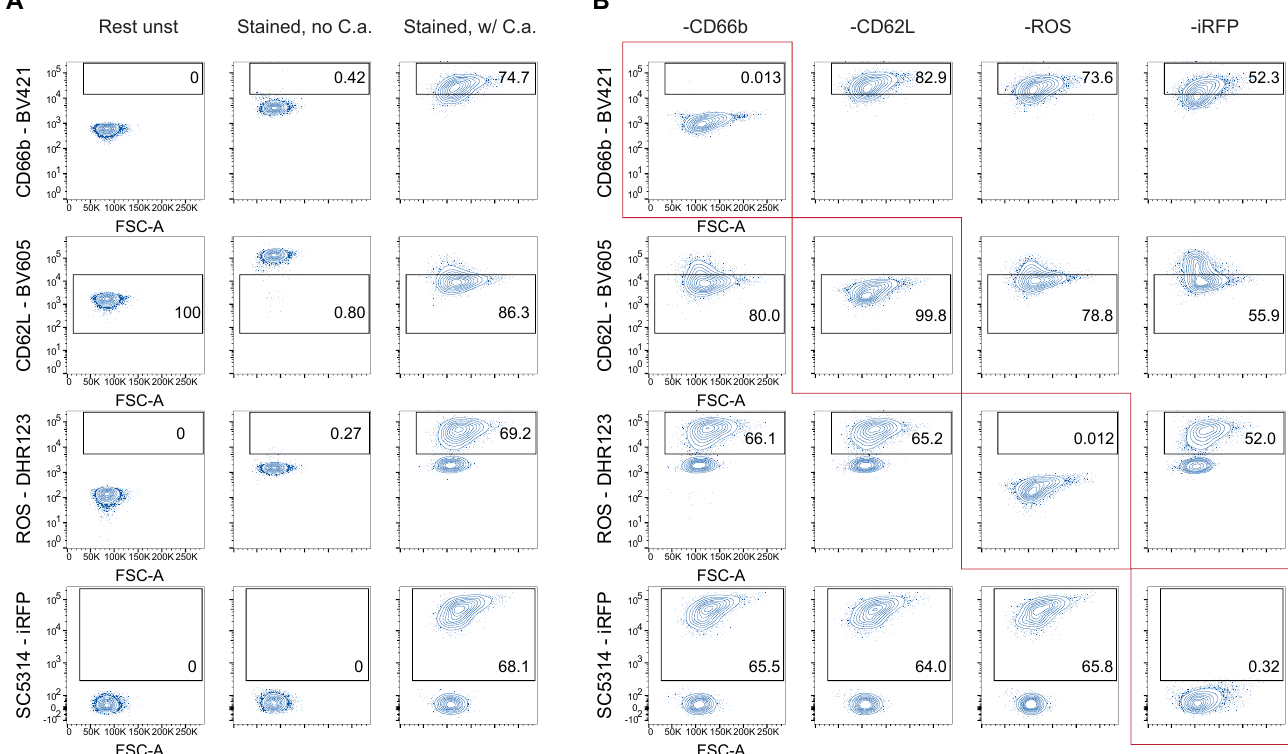
Figure 4. Fluorescence minus one (FMO) controls prove no confounding spectral overlap. ( A , B ) Resting neutrophils (no C.a) and C. albicans challenged neutrophils (w/C.a.) were stained ( A ) and compared to FMO controls ( B ), for which one fluorescent marker was removed at a time while the others were held constant. Red box denotes the FMO and the corresponding